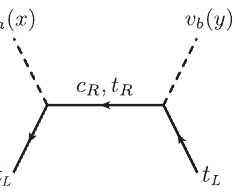
Figure 1. CPV process for generating left-handed top density n L towards BAU, where Higgs bubble wall is denoted symbolically as v a ( x ) and v b ( y )